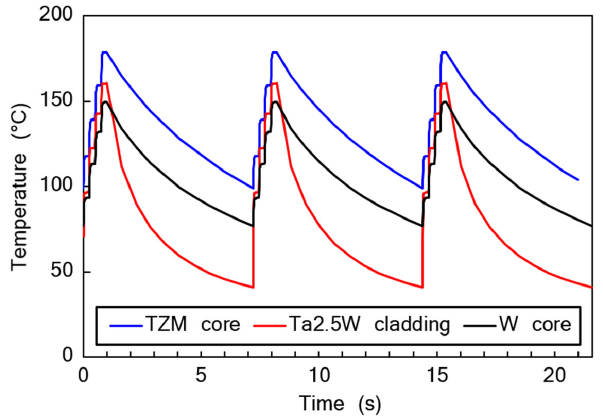
FIG. 4. Maximum temperature evolution during three beam pulses after long-time operation for the BDF target materials, starting from a steady state condition. The results are shown for the most loaded target